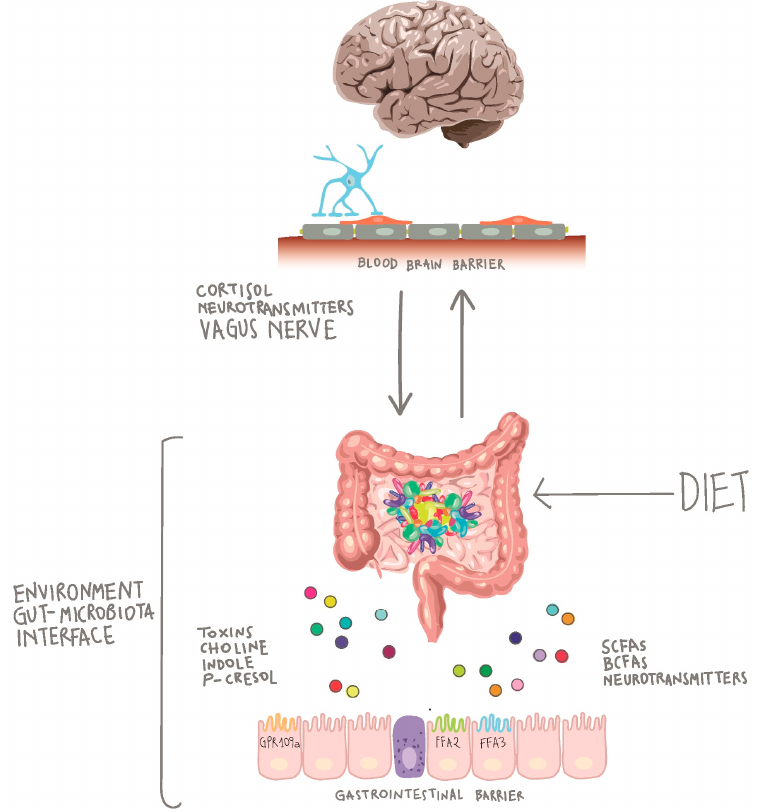
Figure 1. Microbial role in the bidirectional communication between brain and gut. SCFAs: short-chain fatty acids; BCFAs: branched-chain fatty acids.